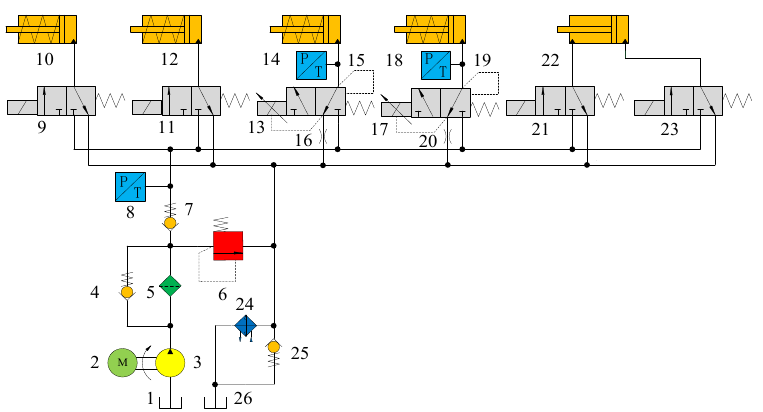
Figure 2. A schematic diagram of an electro-hydraulic shift control system of a pure electric loader.